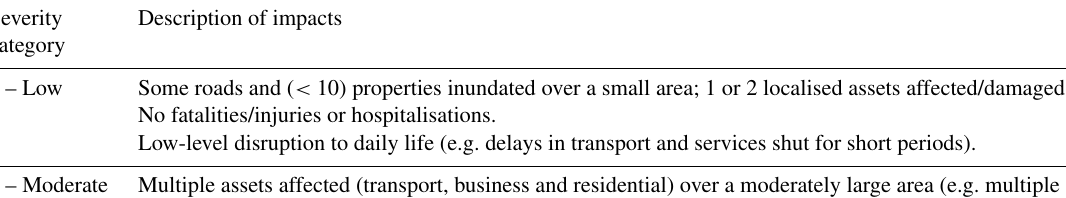
Table 1. Descriptions of impacts required for each impact severity category related to a heavy rainfall event (adapted from Robbins and Titley,